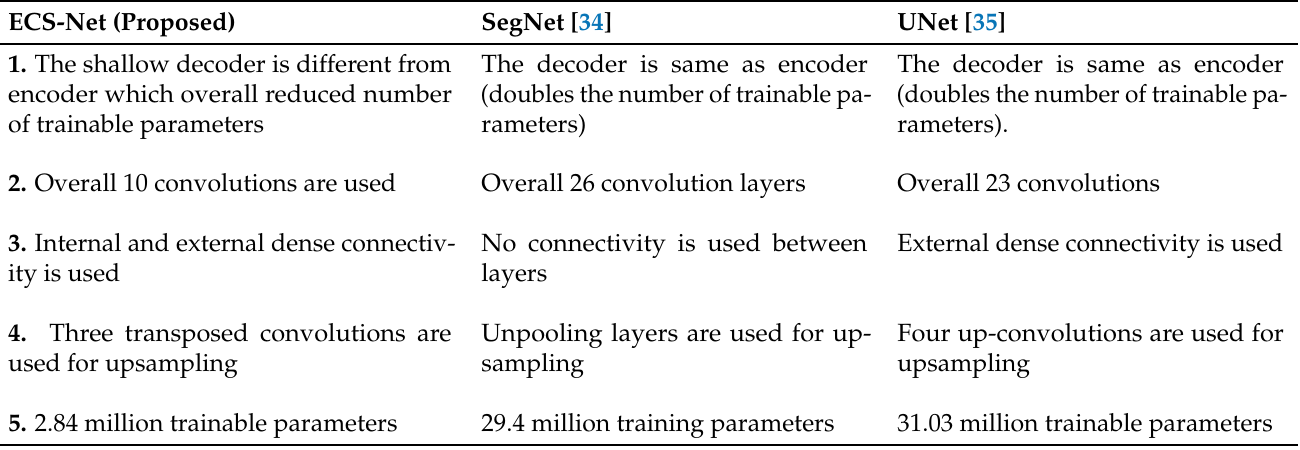
Table 1. Comparison between proposed ECS-Net, SegNet [34], and U-Net [35].